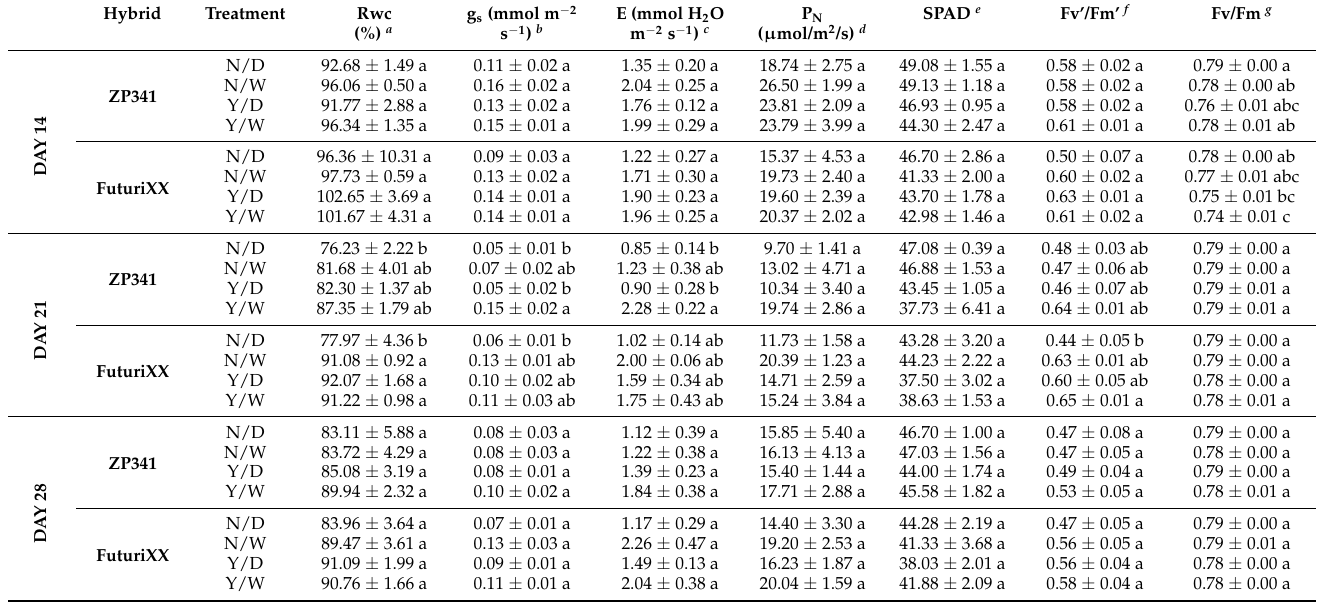
Table 3. Physiological parameters of two maize hybrids subjected to herbivory and to two wa- tering regimes on day 14, day 21 and day 28. Data are presented as mean values ± SE (n = 4). Treatment labels are defined in Table 1; different letters indicate a significant difference among treatments ( p <